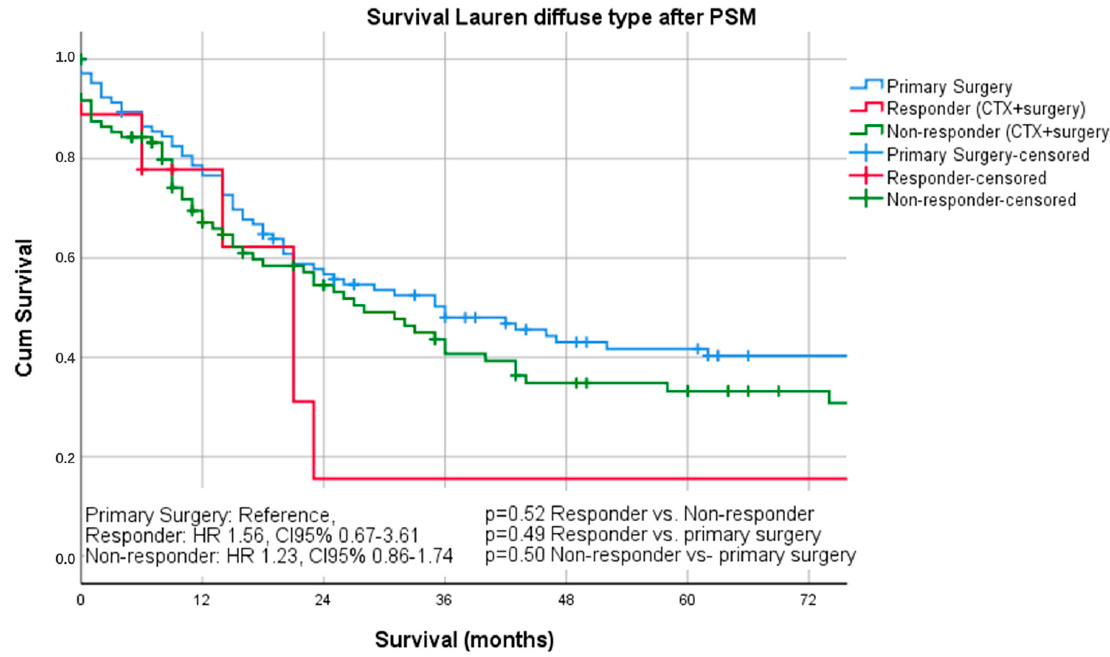
Figure 5. Survival curves for diffuse subtype after PSM differentiated by responders, non- responders and surgery only.